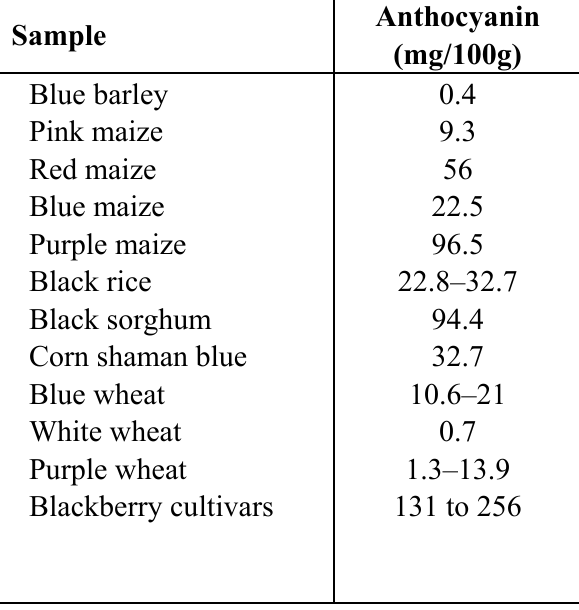
Table 8. Anthocyanin content of different fruits and pigmented cereal grains (mg/100